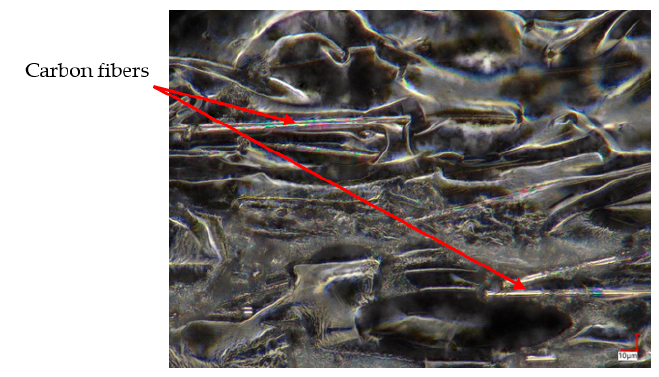
Figure 7. Microscope image of PA6 CF15X structure.